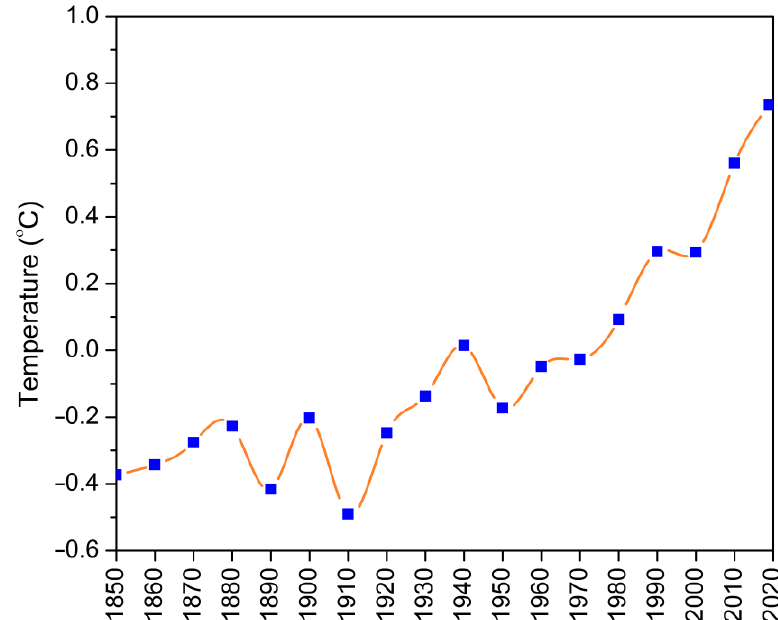
Figure 2. Global average temperature anomaly (Data source: [9]).